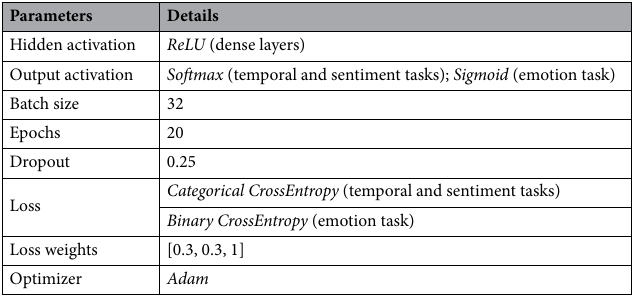
Table 4. Details on numerous hyper-parameters used in our